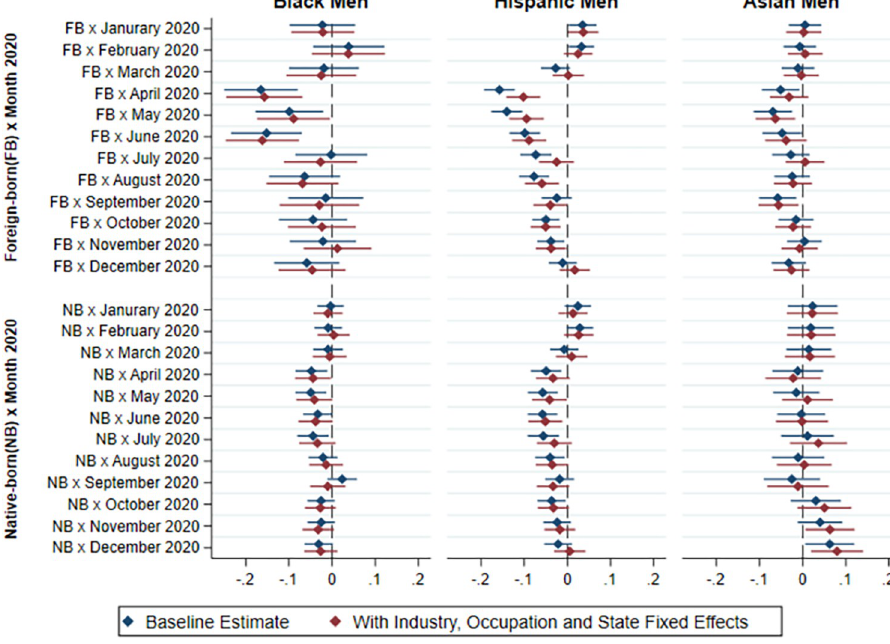
Fig 7. Difference in probability of full-time employment between non-White and native-born White men by immigrant status and race/ethnicity in 2020 relative to 2019 (with industry, occupation and state fixed effects).